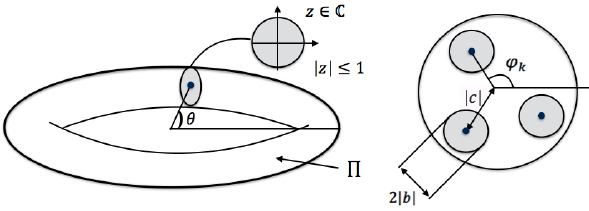
Figure 3. A torus T is parameterized with the coordinates (θ,z) to the left and a mapped cross-section is shown to the